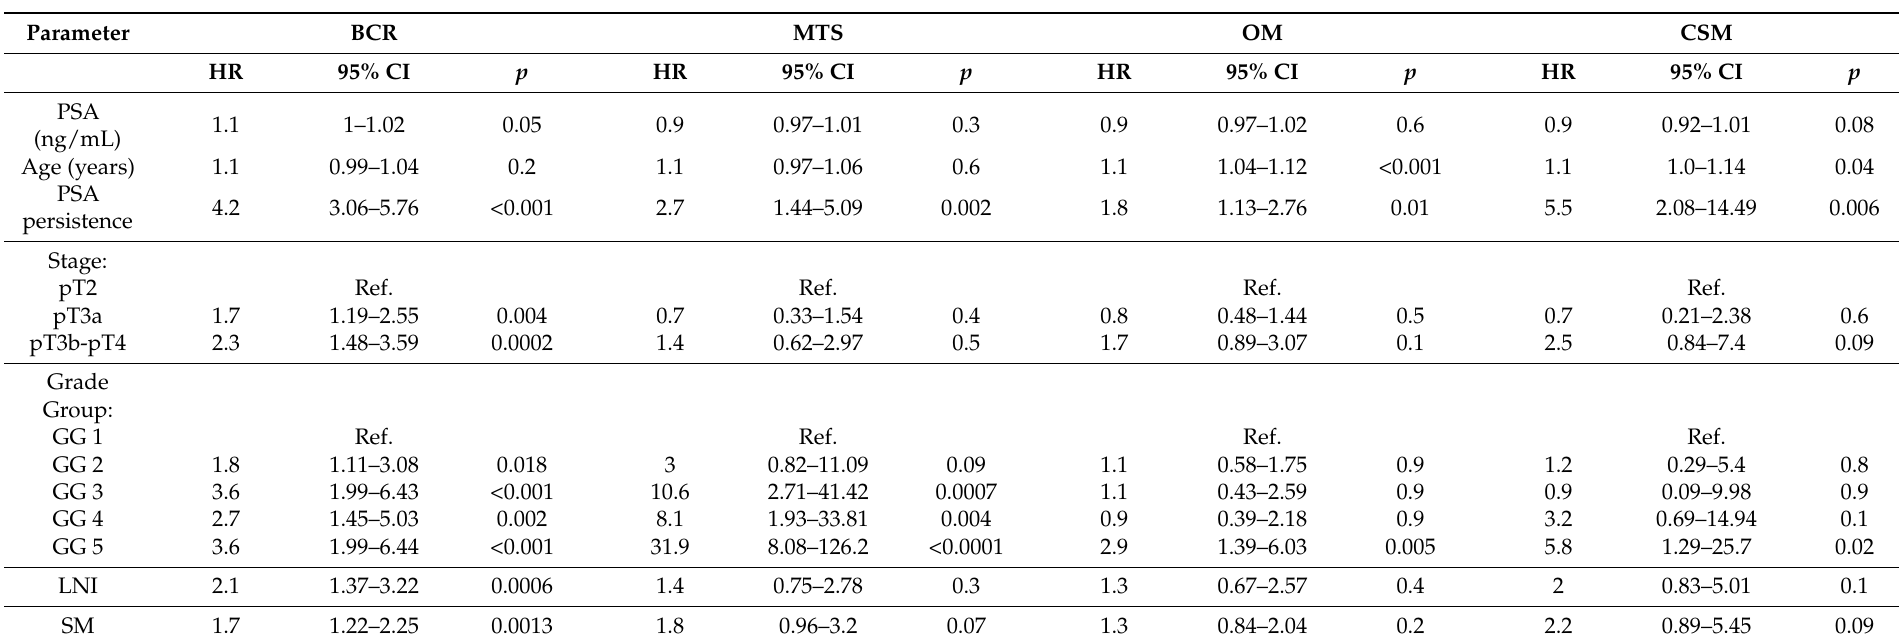
Table 2. Multivariable competing risk analysis of the biochemical recurrence (BCR), developing metastases (MTS), overall mortality (OM) and cancer-specific mortality (CSM) in the whole